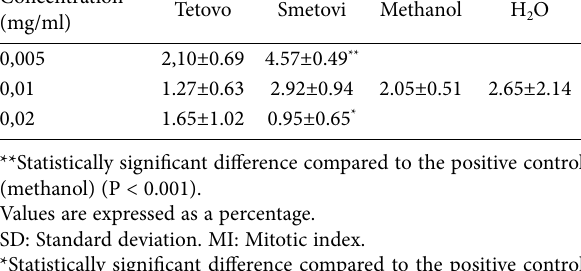
Table 2 The mitotic index of Allium cepa meristematic cells (mean ± SD) exposed to various concentrations of the samples Concentration